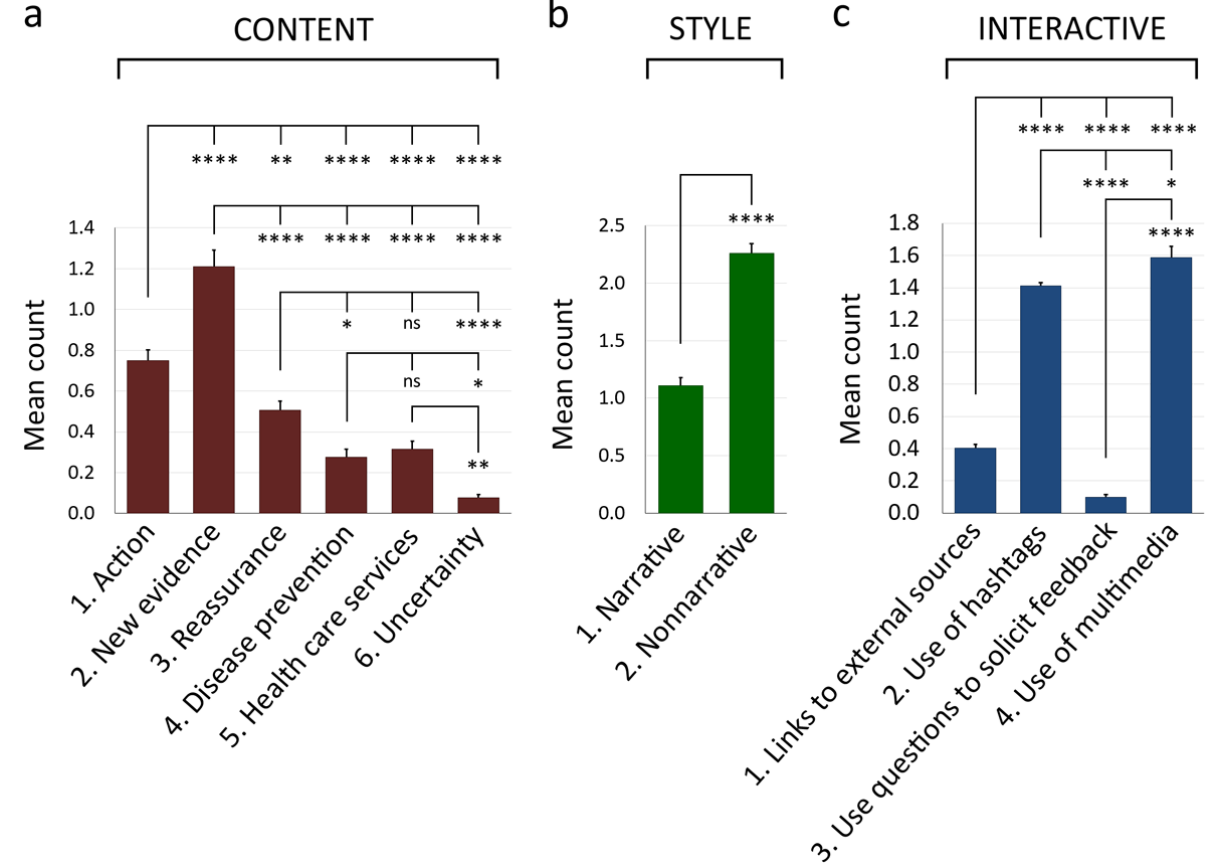
Figure 1. Comparison of the mean counts of subdimensions within each of the three dimensions. (a) Mean counts of subdimensions under the content dimension. (b) Mean counts of subdimensions under the style dimension. (c) Mean counts of subdimensions under the interactive dimension. * P